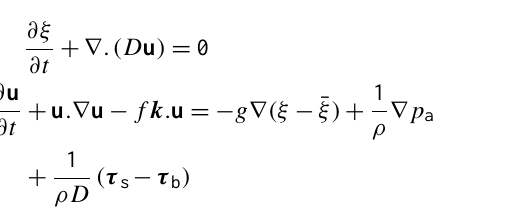
Fig. 6. Time series of the various components of the water elevation ξ at: Dunkerque (top), Saint-Malo (middle), Le Conquet (bottom), for the November 2007 (left) and March 2008 (right) events.